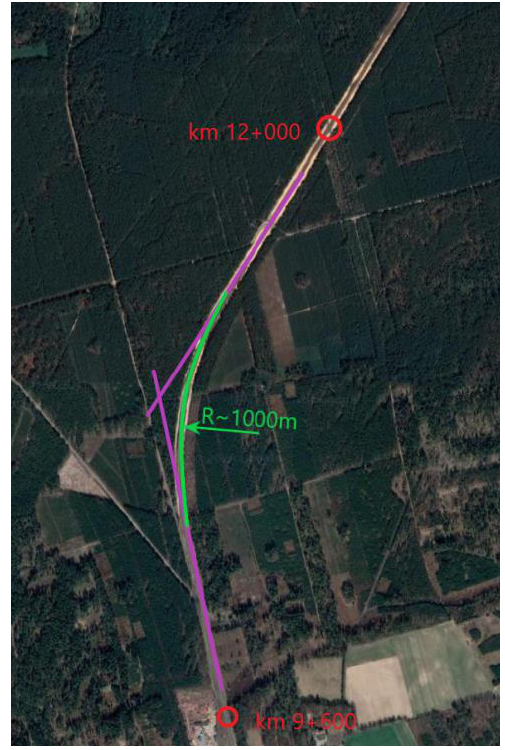
Figure 2. Location plan of the measurement testing ground.